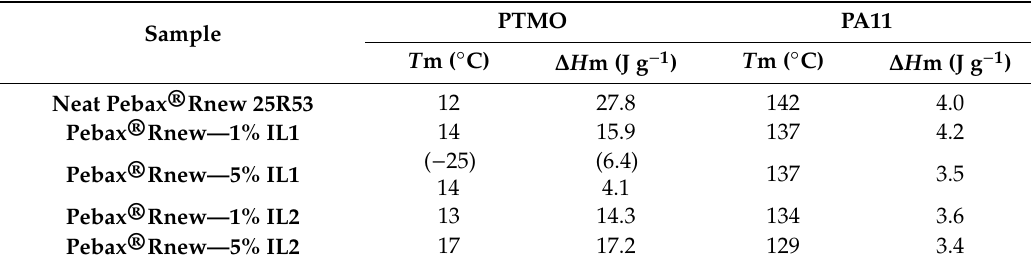
Table 1. Melting temperatures ( T m) and enthalpy of fusion ( ∆ H m) of PTMO and PA blocks in the second heating run of Pebax ® Rnew and Rnew / ILs